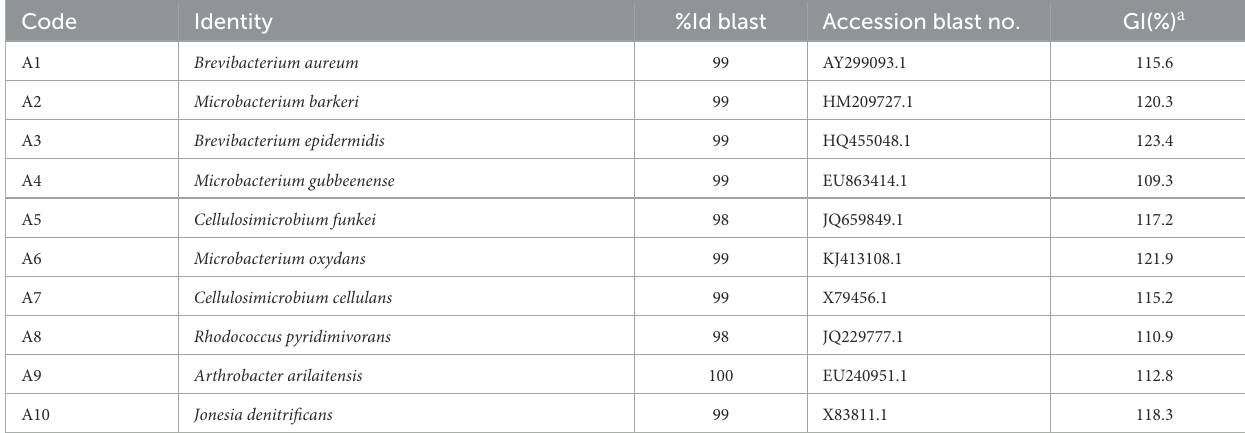
TABLE 1 Collection of selected strains based on their toxonomic order (Actynomicetales) and their phytostimulant potential on watercress seeds (GI ≥ 100%).